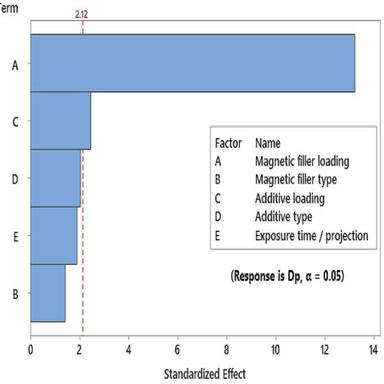
Pareto chart of factors affecting the response variable 'depth of penetration'.